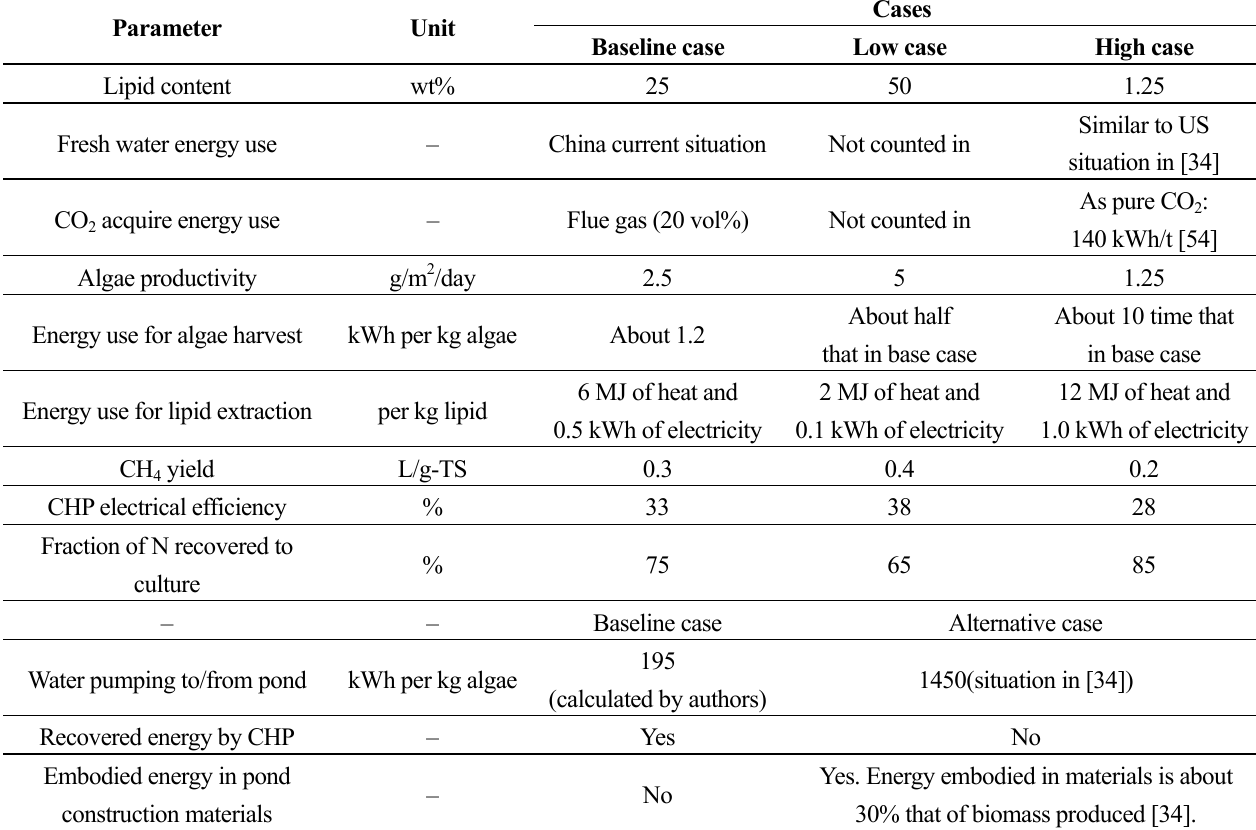
Table 8. Details of the low-emission, high-emission and alternative cases in this